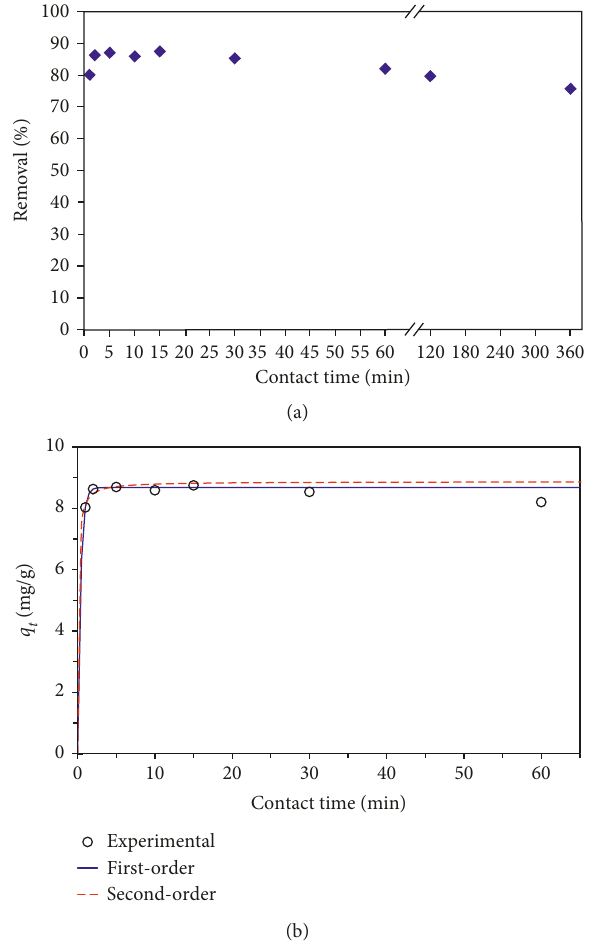
15min; Co 50mg/L; T 28 (cid:29) (cid:29) (cid:29)